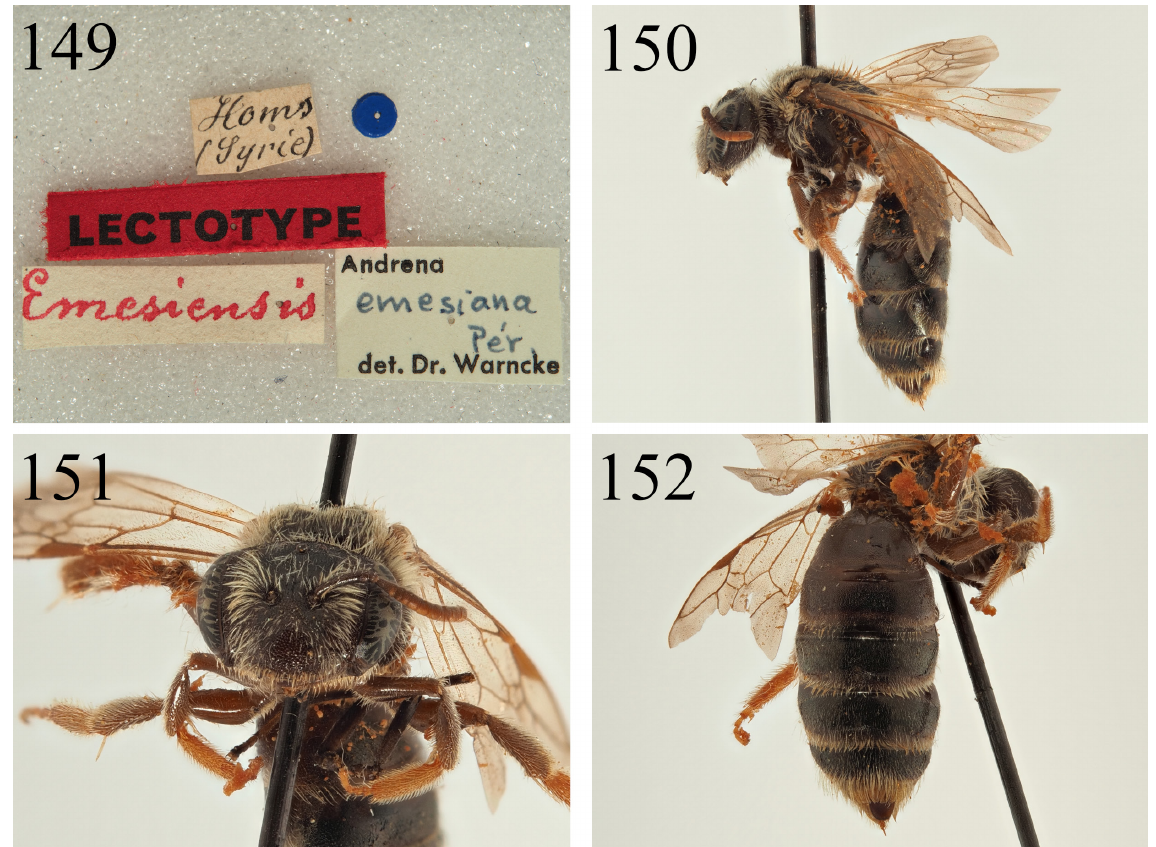
Figs 149–152. Andrena emesiana Pérez, 1911, ♀, lectotype (MNHN). 149 . Labels, detail. 150 . Profile. 151 . Face. 152 .